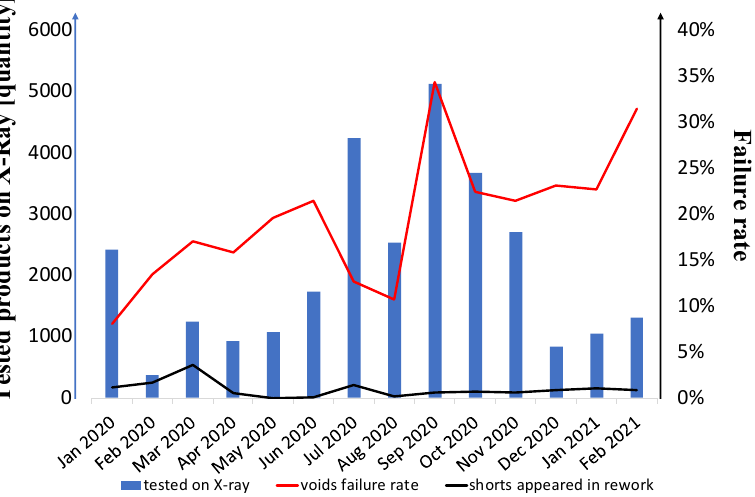
Figure 4. Values of the quality index in selected months of production.